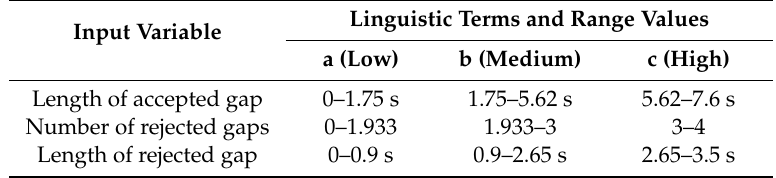
Table 1. Membership functions used with name of input variables and range values.